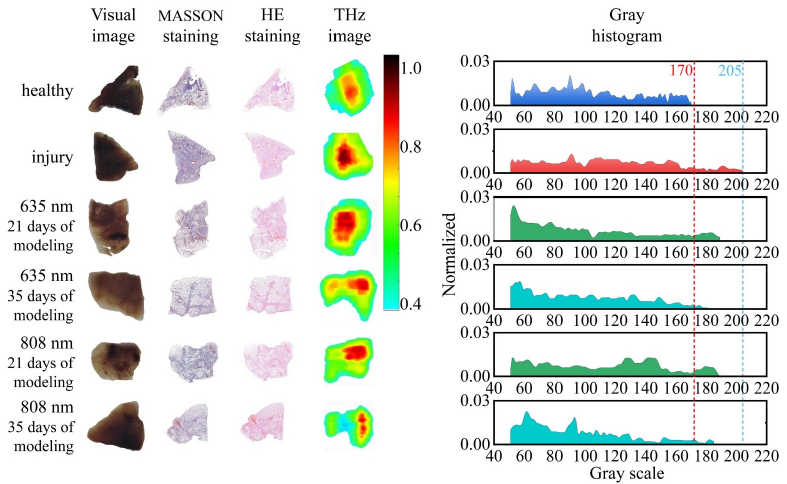
Figure 3. Images of the ALI samples at different stages of LLLT including visual images, MASSON staining images, HE staining images, THz images, and corresponding gray histograms of THz images.